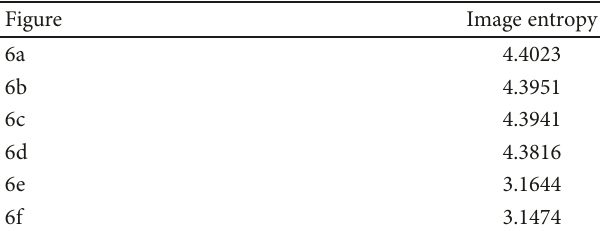
Table 2: Image entropy.